Question: Which kind of chart has been used to present this data?
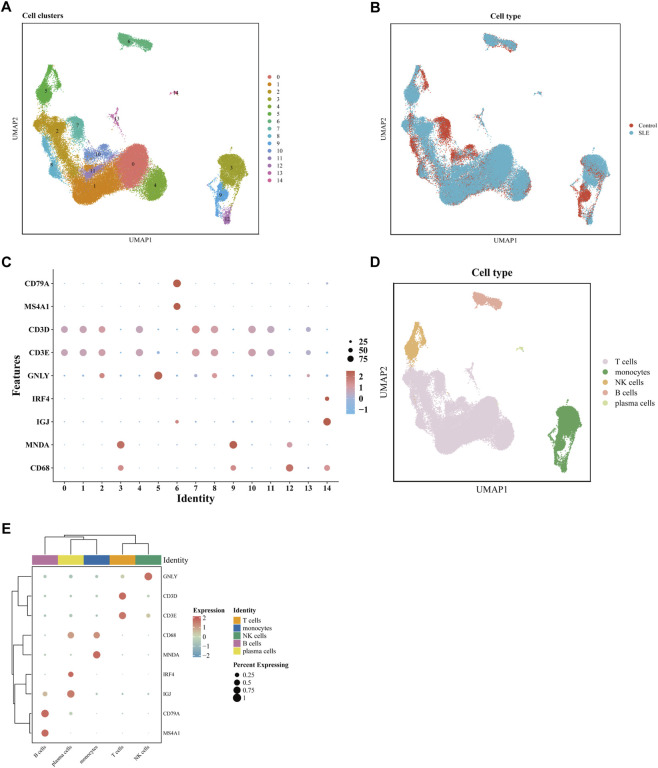
Answer: scatter